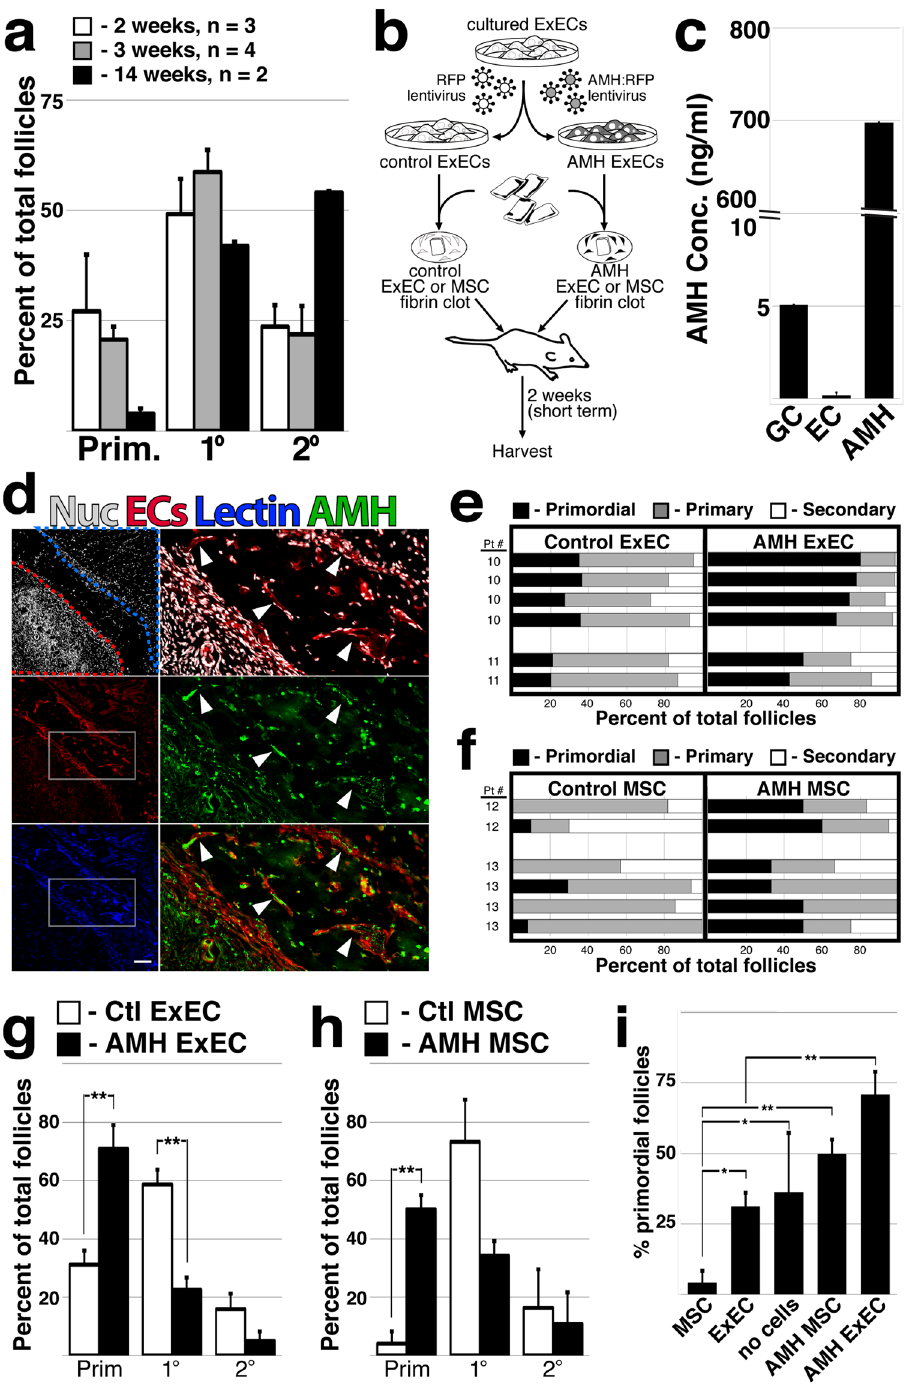
Figure 4. ExECs engineered to express AMH preserve a quiescent follicular pool. ( a ) The proportion of follicles was quantified for multiple ovarian tissue fragments from the same patient that were xoengrafted for long and short term intervals; n = 3 at 2 weeks, n = 4 at 3 weeks and n = 2 at 14 weeks. ( b ) Scheme of the experimental design. Frozen-thawed human ovarian tissue was encapsulated in a fibrin clot, with either ExECs/MSCs transduced with an RFP lentiviral particle serving as a control, or ExECs/MSCs transduced with an AMH- RFP lentiviral particle generating AMH-ECs/MSCs. The clots were transplanted into oophorectomized NSG mice and harvested at 2 weeks. ( c ) ExECs were transduced with lentivirus encoding secreted human AMH; cell culture supernatant of AMH-transduced ExECs was compared to COV-434 culture granulosa cell tumor line and control ExECs. ( d ) Two weeks after transplant, ovarian tissue fragments that were co-transplanted with AMH-ExECs were stained with an antibody specific for AMH protein. ( e ) The relative proportion of follicles in xenografts co-transplanted with control and AMH-ExECs was quantified after 2 weeks (n = 6). ( f ) The relative proportion of follicles in xenografts co-transplanted with control and AMH-MSCs was